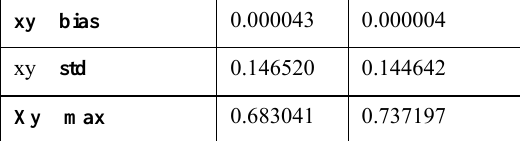
Table 2. Adjustment result of the UCD